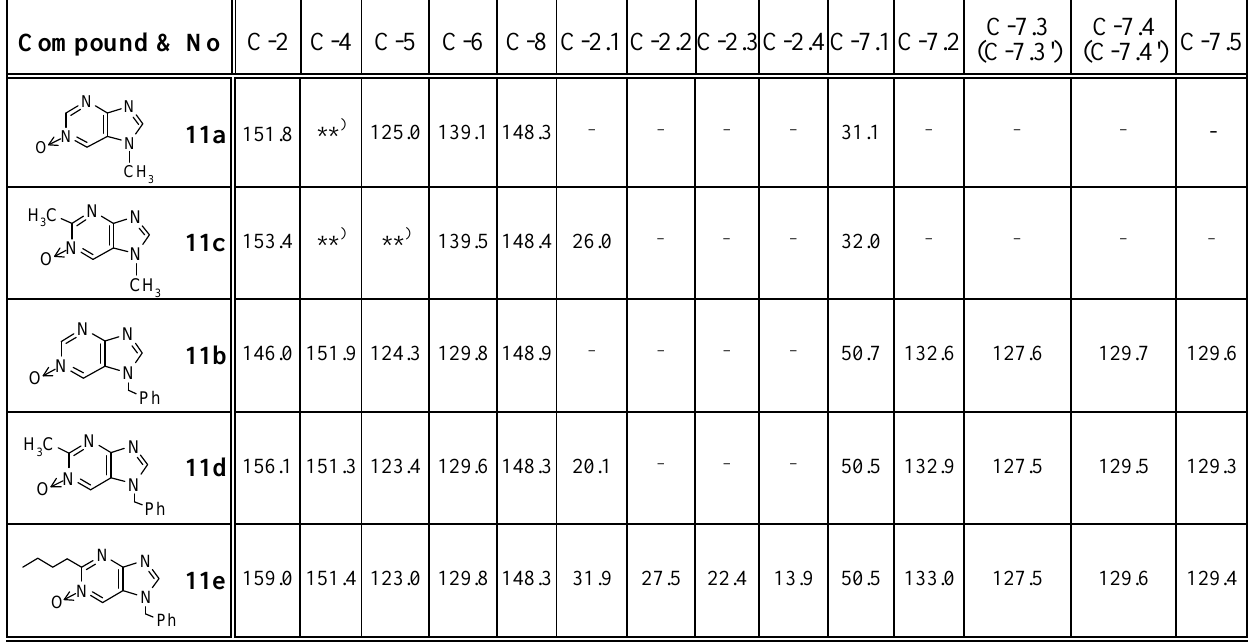
Table 2. 13 C NMR spectra of purine mono - N -oxides (in CDCl Compound &